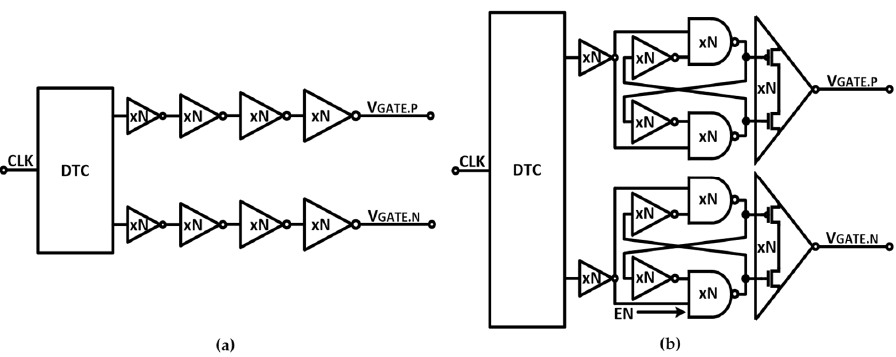
Figure 6. Simplified gate driver structures: ( a ) Conventional gate driver and ( b ) proposed non- overlapping gate driver.